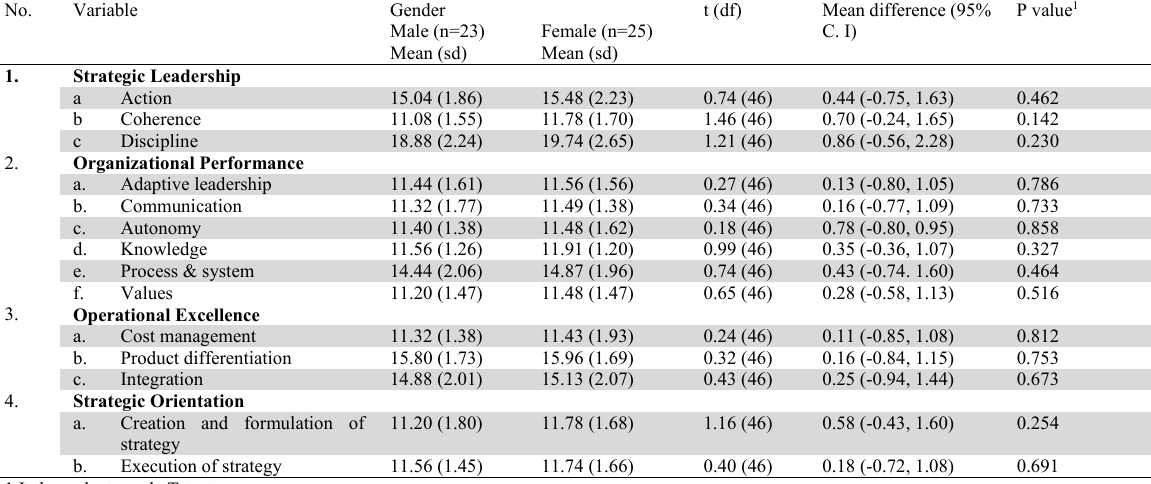
The effect of gender on scores in Proton (n=48)